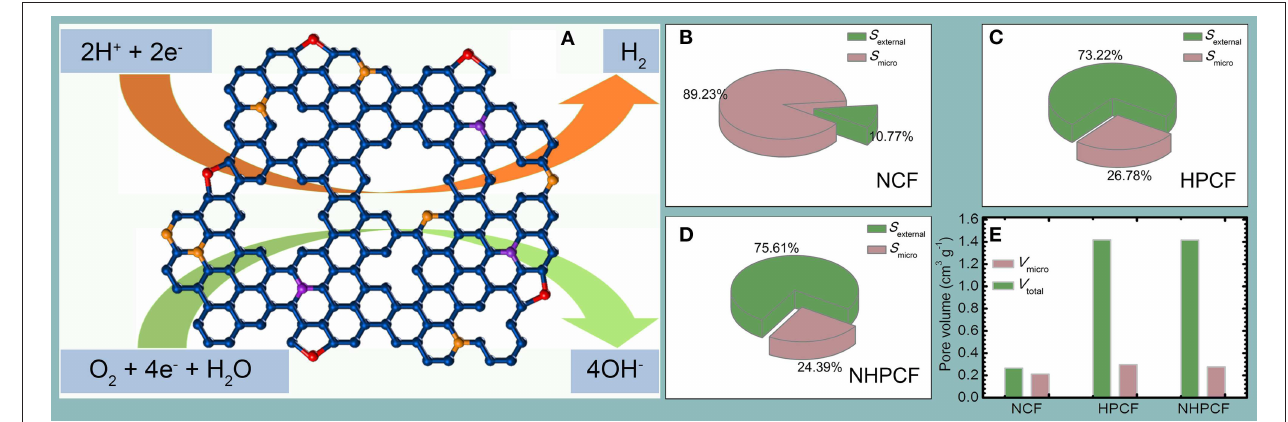
FIGURE 5 | The (A) proposed catalytic mechanism of NHPCF CAC for HER and ORR, (B–D) surface areas composition, and (E) pore volumes of NCF, HPCF, and